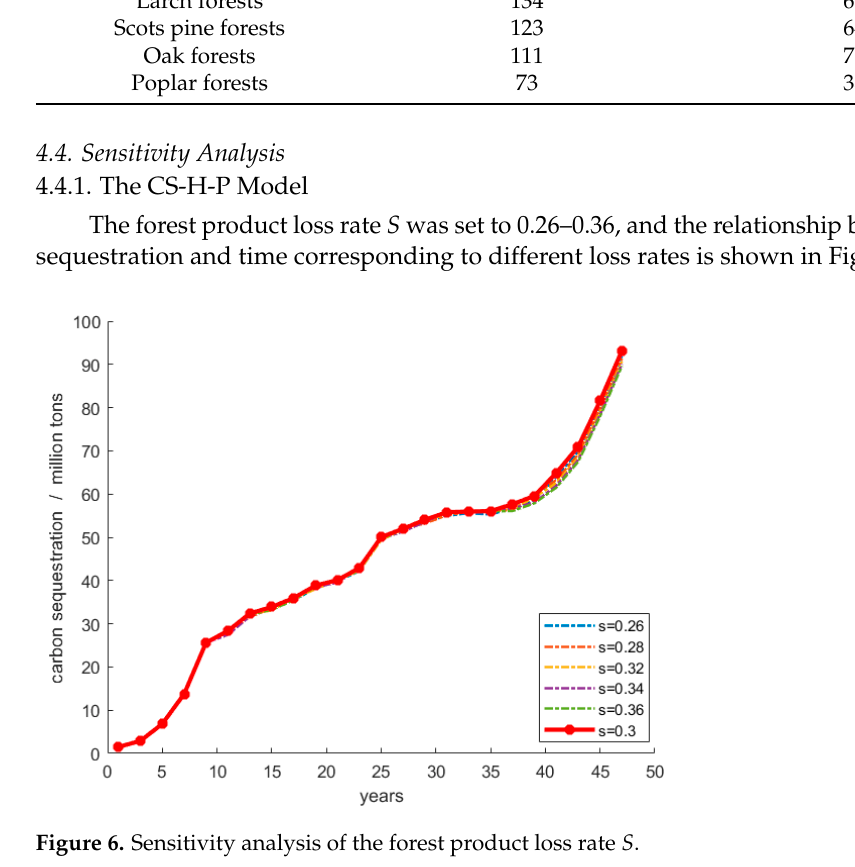
Table 3. Table of new regeneration cutting ages.